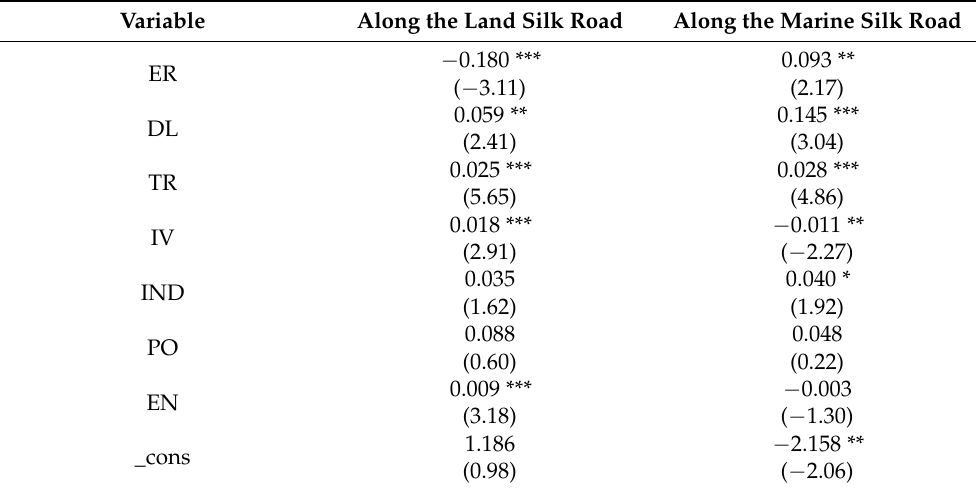
Table 10. Tobit regression results.